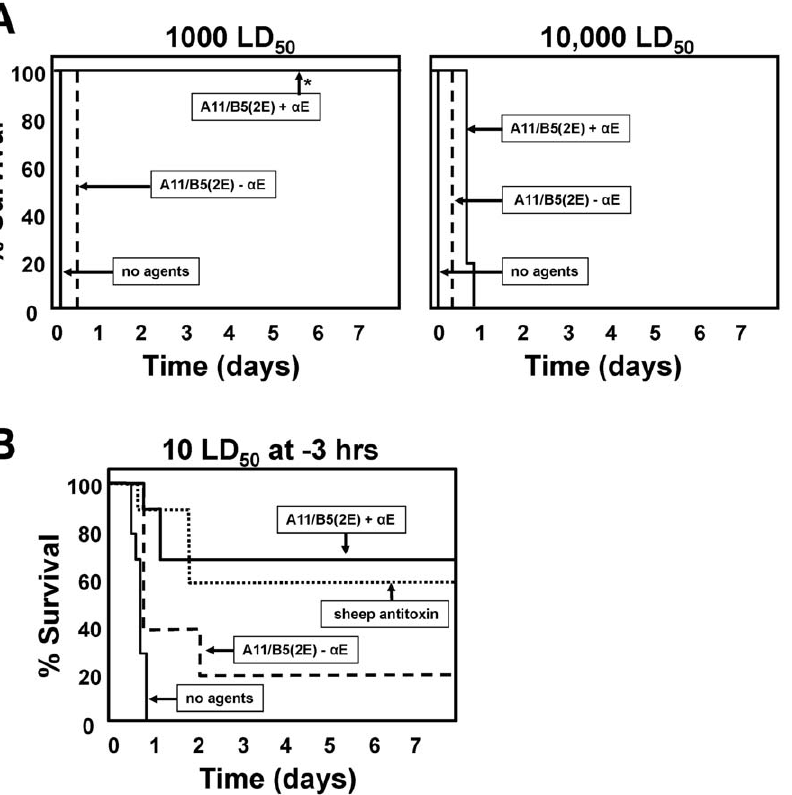
Figure 6. BoNT/B intoxication is prevented by heterodimer antitoxin agents in two models of BoNT/B intoxication in mice. Protection of mice from BoNT/B lethality by administration of a double-tagged heterodimer of anti-BoNT/B VHHs ciB-A11 and ciB-B5 (A11/B5(2E)) + / 2 clearing Ab. Time to death is plotted as % survival as a function of time. An asterisk indicates that mice did not display any symptoms of intoxication. The results shown are combined from two replicate studies. ( A ) Groups of mice were co-administered the indicated LD 50 dose of BoNT/B together with no agents or the A11/B5(2E) heterodimer VHH with or without anti-E-tag clearing Ab ( a E). ( B ) Groups of mice were administered a 10 LD 50 dose of BoNT/B and three hours later administered no agents, sheep anti-BoNT/B antiserum or the A11/B5(2E) heterodimer VHH with or without anti-E-tag clearing Ab ( a E).